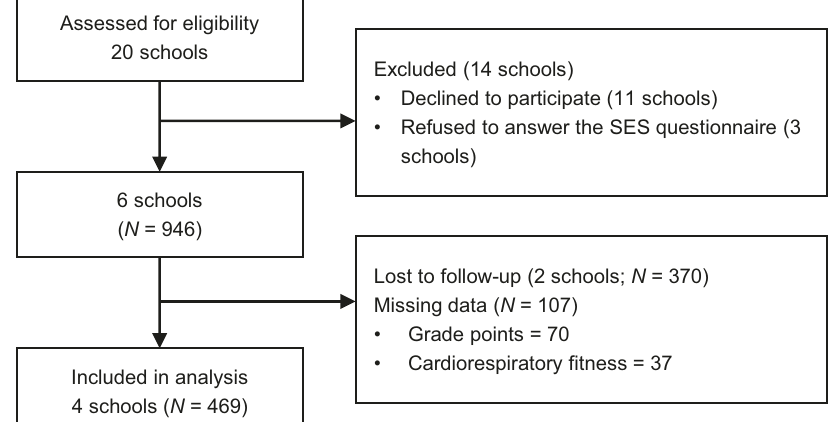
Fig. 2 Flow diagram of participant recruitment and follow-up procedures.